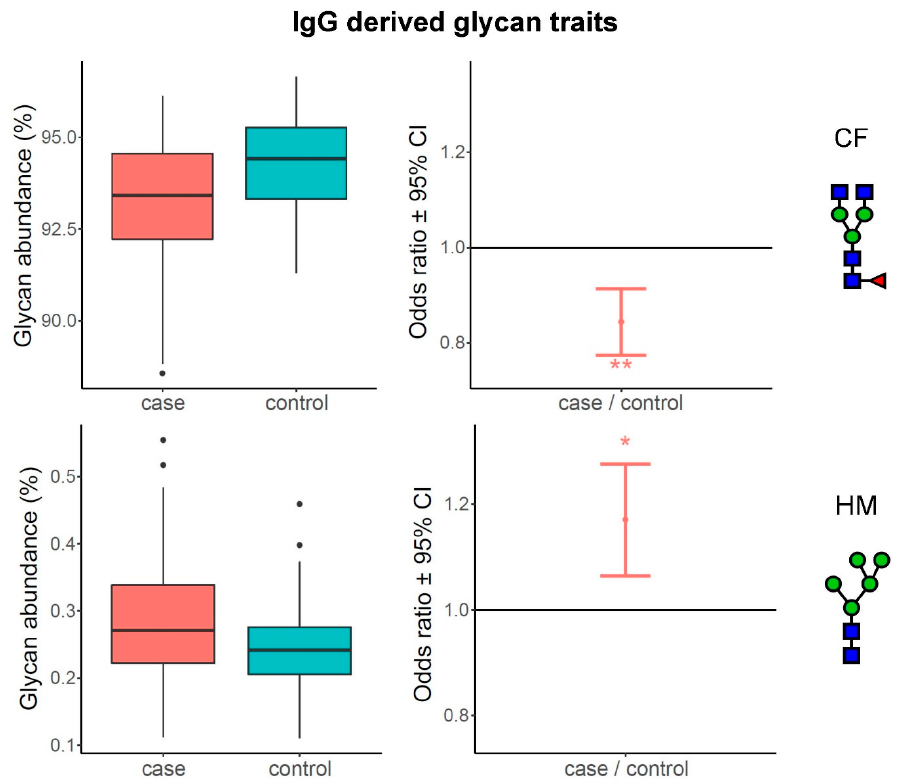
Figure 2. Most prominent differences between MS subjects and matched controls in IgG derived glycan traits. The left part of the figure shows boxplots representing differences in glycan abundances, while the right part shows odds ratio plots, resulting from post-hoc tests. Boxes in the boxplot are ranging from 25th to 75th percentile, with the median represented as a line inside the box. The whiskers of the boxplot extend from both percentiles, 75th percentile for upper whisker and 25th for lower whisker, to the values within 1.5 × IQR. IQR is the inter-quartile range, also known as the distance from the first to the third quartile. Data outside the whiskers’ ends are outliers, represented with black dots, and are plotted individually. On the odds ratio plots, middle dot represents odds ratio value for represented derived glycan trait surrounded by its 95% confidence interval (CI). Odds ratio of 1.0 means that there is no difference between compared groups for the given trait. Asterisk symbols represent statistical significance: * < 0.05; ** < 0.01.